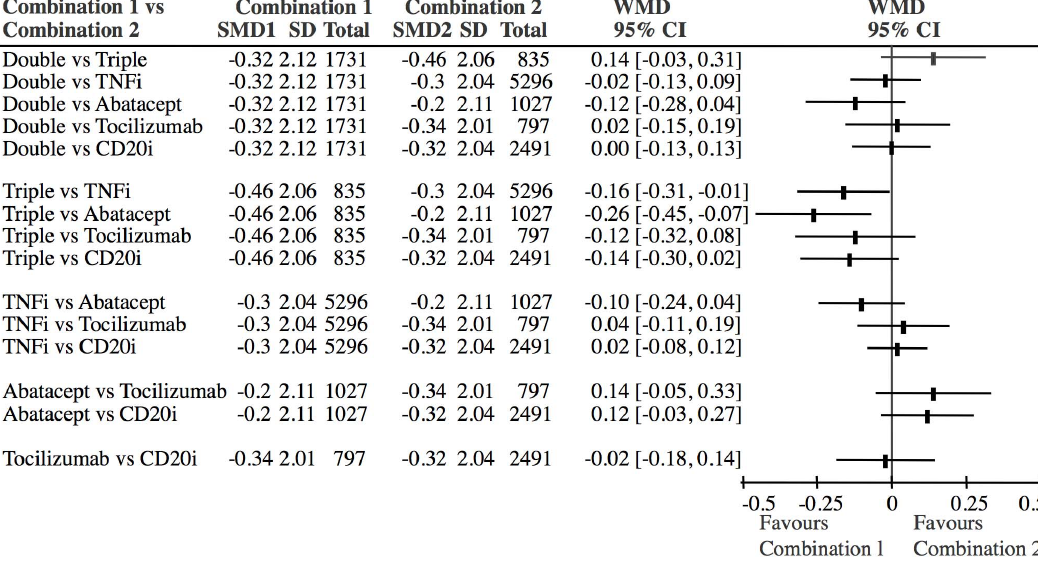
Figure 10. Indirect comparisons of different combination treatments. There is a trend towards triple treatment being superior to abatacept and TNFi. All other differences between the combination treatments are non-significant. Abbreviations: SMD: Standardized mean difference. WMD: Weighted mean difference (SMD1-SMD2).